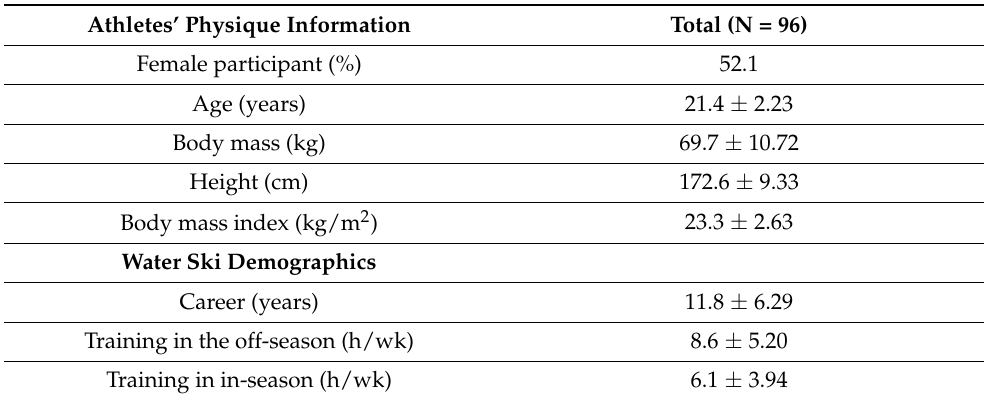
Table 1. Participants’ basic characteristics and water-ski